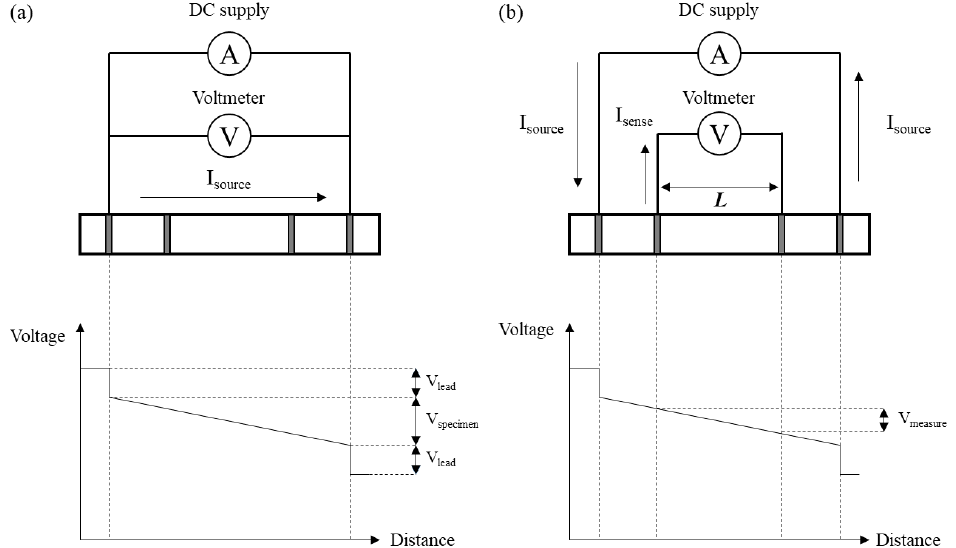
Figure 1. The comparison between DC 2-point method ( a ) and DC 4-point method ( b ).